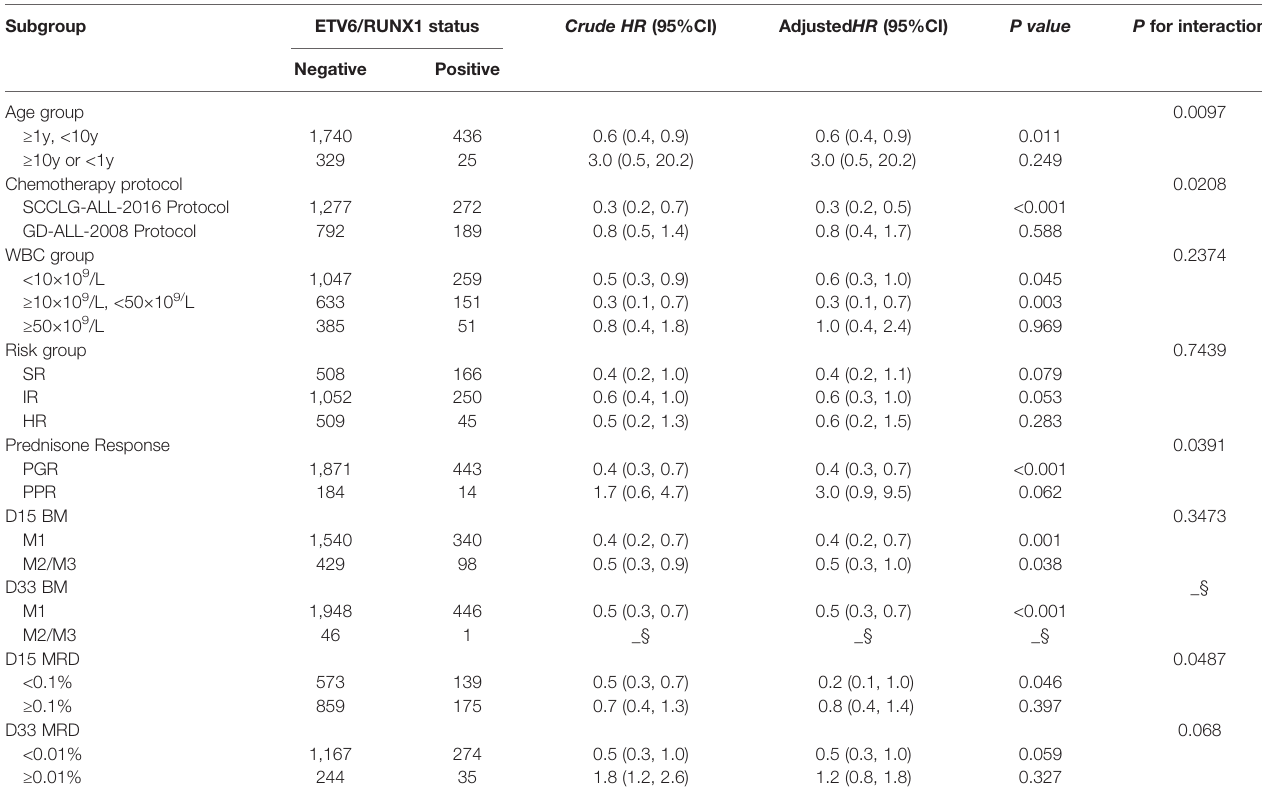
TABLE 4 | Subgroup analysis of the associations between ETV6/RUNX1 status and EFS.